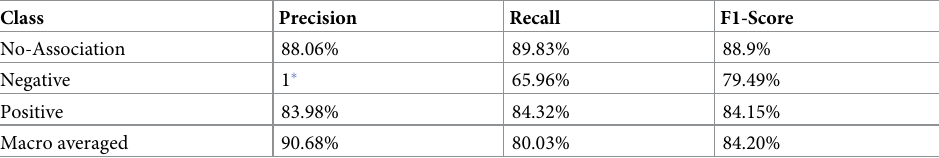
Table 1. The class-wise performance metrics for the best CNN model, implementing word, position, part of speech and chunk embedding features, used for spice-disease relationship extraction. All negative associations were cleaned